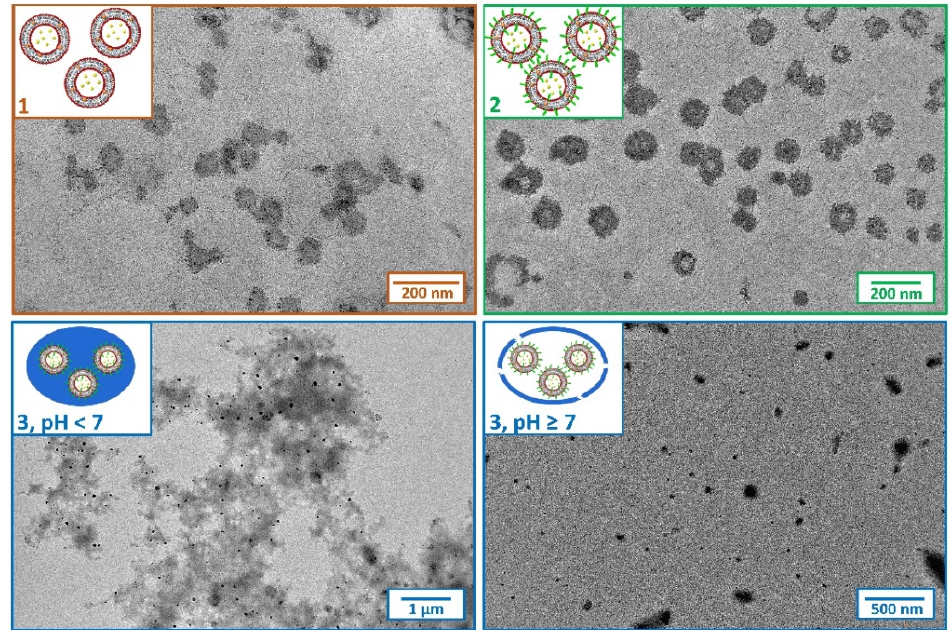
Figure 3. TEM images of Types 1–3 liposomes loaded with Cur and HT. The initial concentrations of Cur and HT are 40 μM and 22 mM, respectively. The sketches provide a qualitative description of the realized systems, and the dimensions of the different components are not to scale.